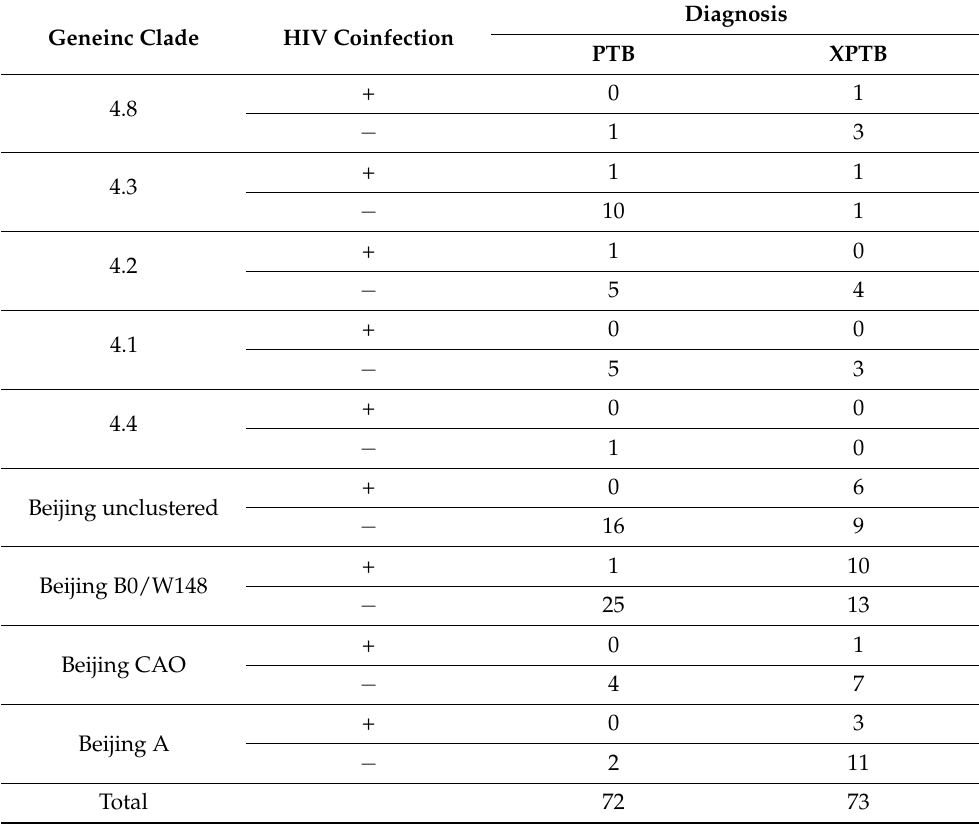
Table 5. Number of M. tuberculosis isolates obtained from patients with different TB localization and